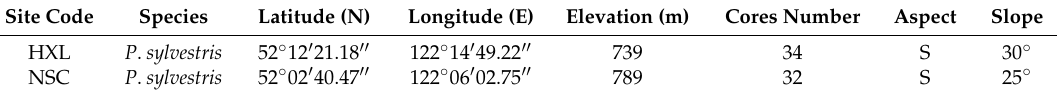
Figure 1. ( a ) Positions of P . sylvestris sampling locations (red solid triangle) and the meteorological stations (green solid square) in the northern Daxing’anling Mountains of Inner Mongolia, northeastern China. Upright shows the geoposition in China; ( b ) Photograph of a typical P . sylvestris tree and the slope at the study site. Table 1. Information about the two sampling sites in the northern Daxing’anling Mountains.